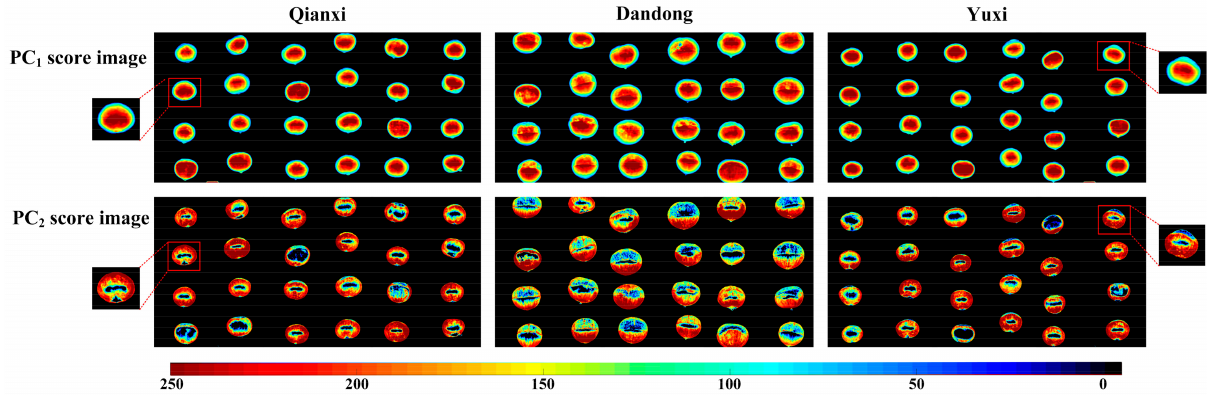
Figure 5. The PC 1 and PC 2 score images. PC 1 , first principal component, and PC 2 , second principal